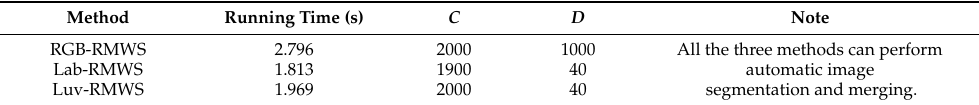
Table 4. Comparison of the running time of the segmentation experiments.